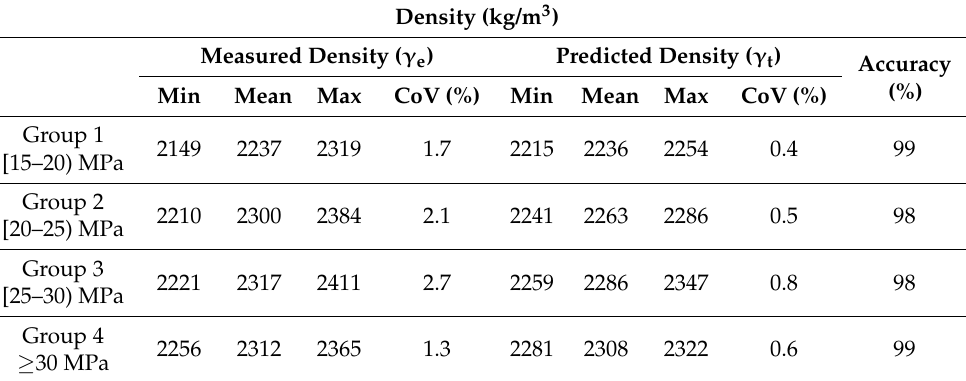
Table 1. Air-dry